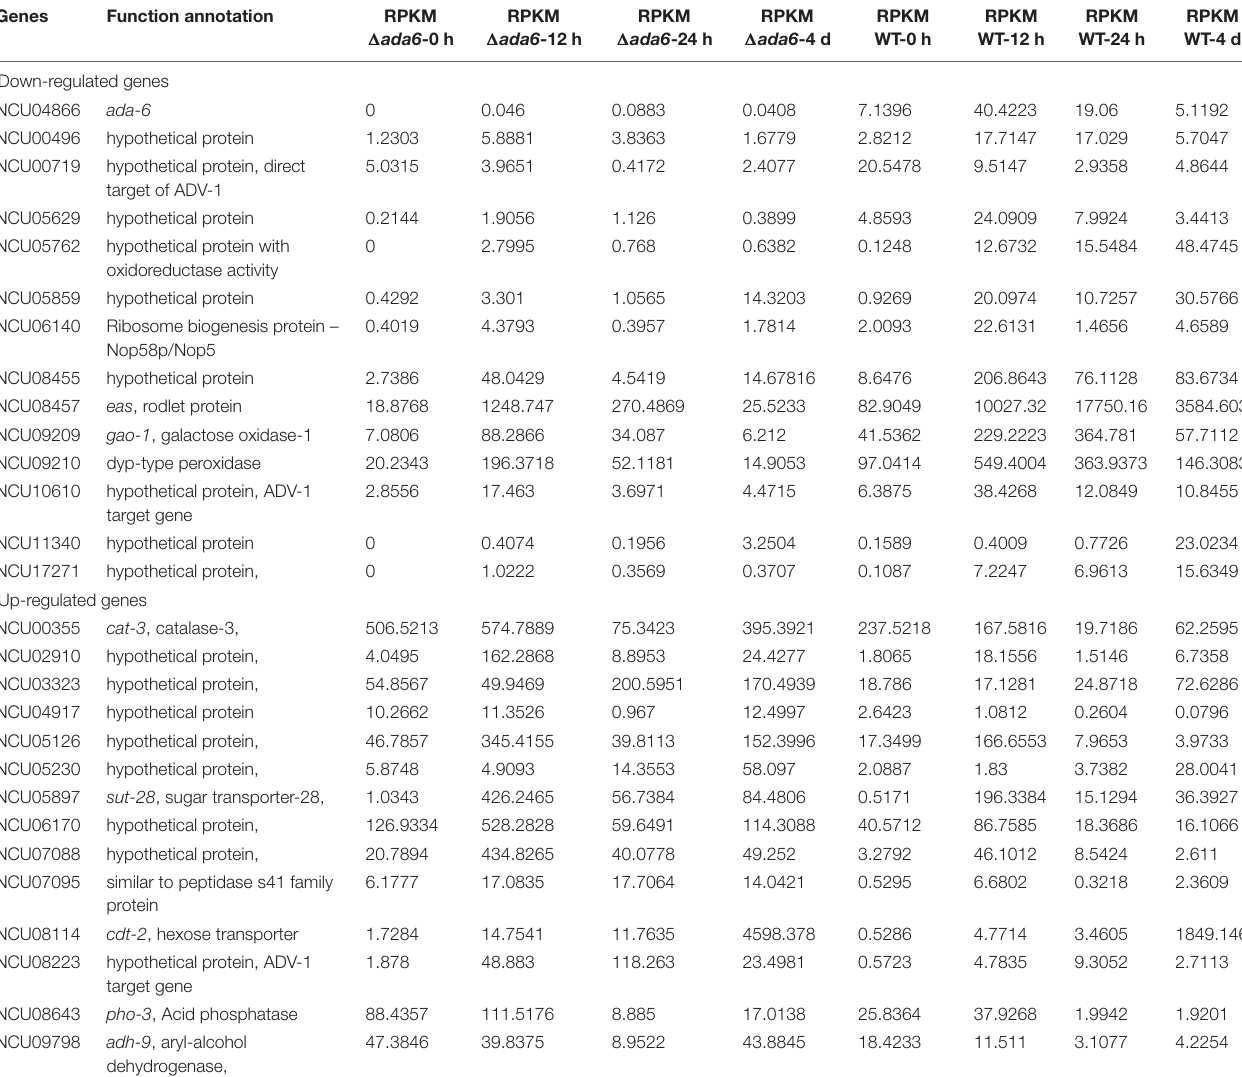
TABLE 1 | Genes transcriptionally response to ada-6 deletion under all tested